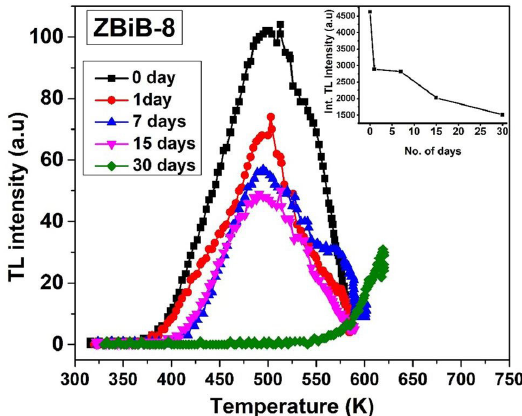
Figure 13. Thermally faded TL intensity curves of ZBiB-8 glass over a period of month.